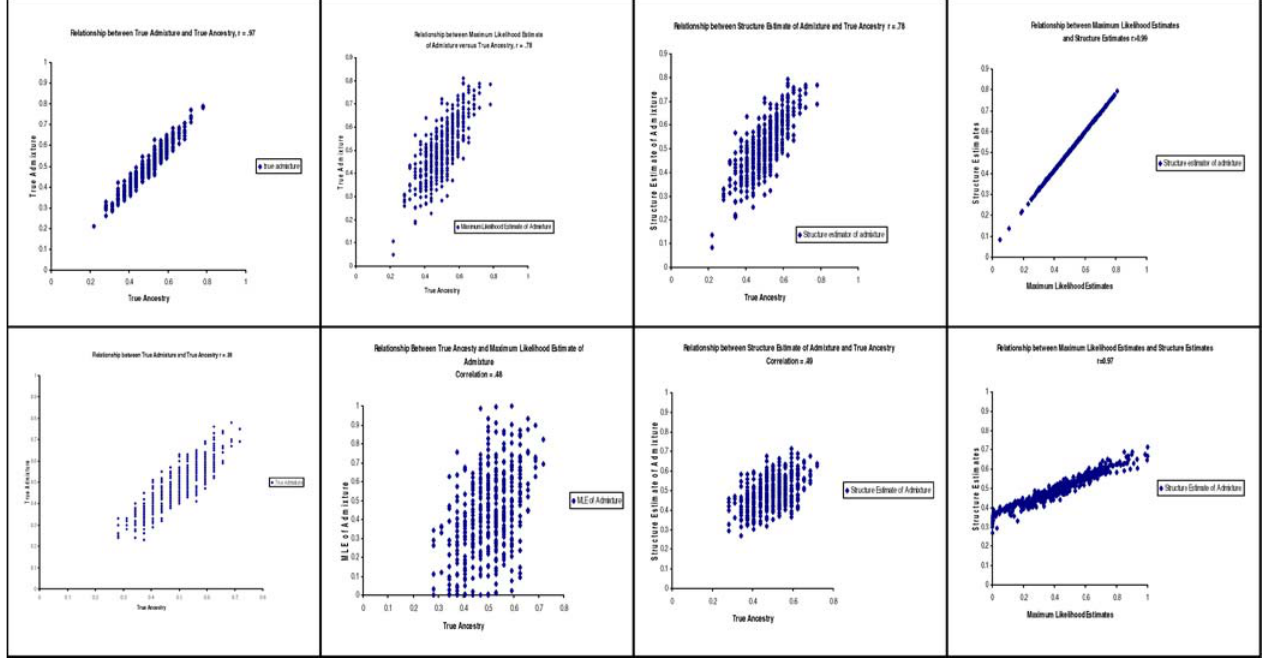
Figure 4. Reliability of Individual Admixture Estimates Used as Estimates of Individual Ancestry We simulated a randomly mating population or organisms based upon the ‘‘ island model ’’ or intermixture admixture process [16]. Because the data are simulated, true individual ancestry and true individual admixture are known for each individual. True individual ancestry is displayed on each abscissa. The top four panels each contain data from a simulation of 500 admixed individuals five generations after the admixture event. Two hundred ancestry informative markers are genotyped with an average allele frequency difference between the original parental populations of 0.3. Founders (250 from each parental population) were simulated for use in the procedures that estimated individual admixture. The bottom four panels also each contain data from a simulation of 500 admixed individuals five generations after the admixture event. However, here only 50 ancestry informative markers are genotyped with an average allele frequency difference between the original parental populations of only 0.2 and only 40 founders (20 from each parental population) were simulated for use in the procedures that estimated individual admixture. Maximum likelihood estimates were calculated using Tang et al.’s [10] method. Structure estimates were produced using software described here [8,64]. Several points are noteworthy. First, our results in the top and bottom rightmost panels recapitulate results obtained by Tang et al. [10] and Zhu et al. [16]. However, our results also show that even though two methods of estimating individual admixture may produce correlations very close to 1.0, the correlation of these estimates with true ancestry may be far lower (only ; .80 in our upper row and only ; .50 in our lower row). Finally, the two leftmost figures highlight the fact that there are important differences between true admixture and true ancestry. DOI: